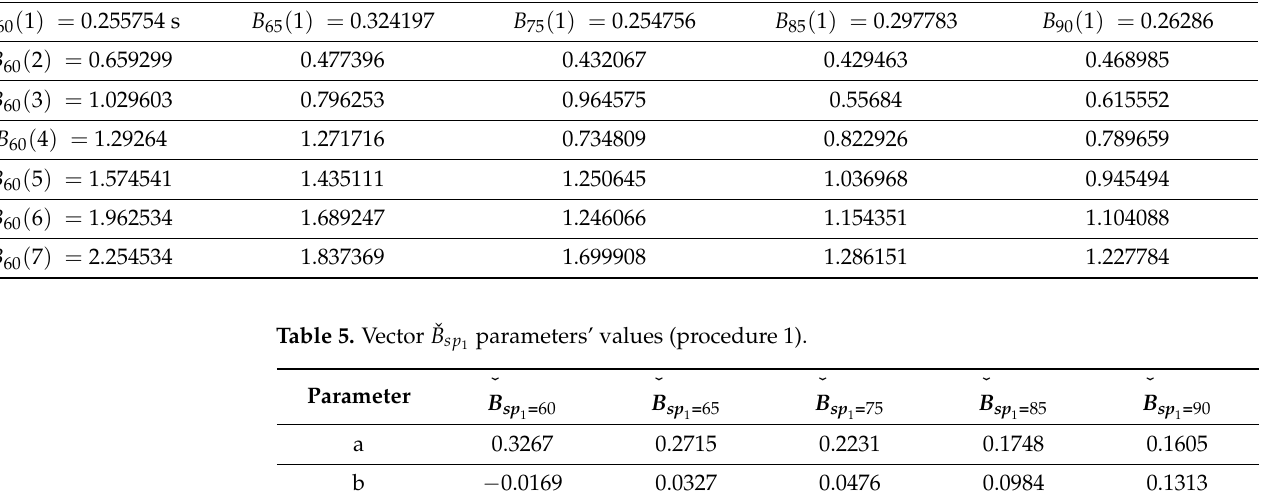
Table 4. Vectors B sp